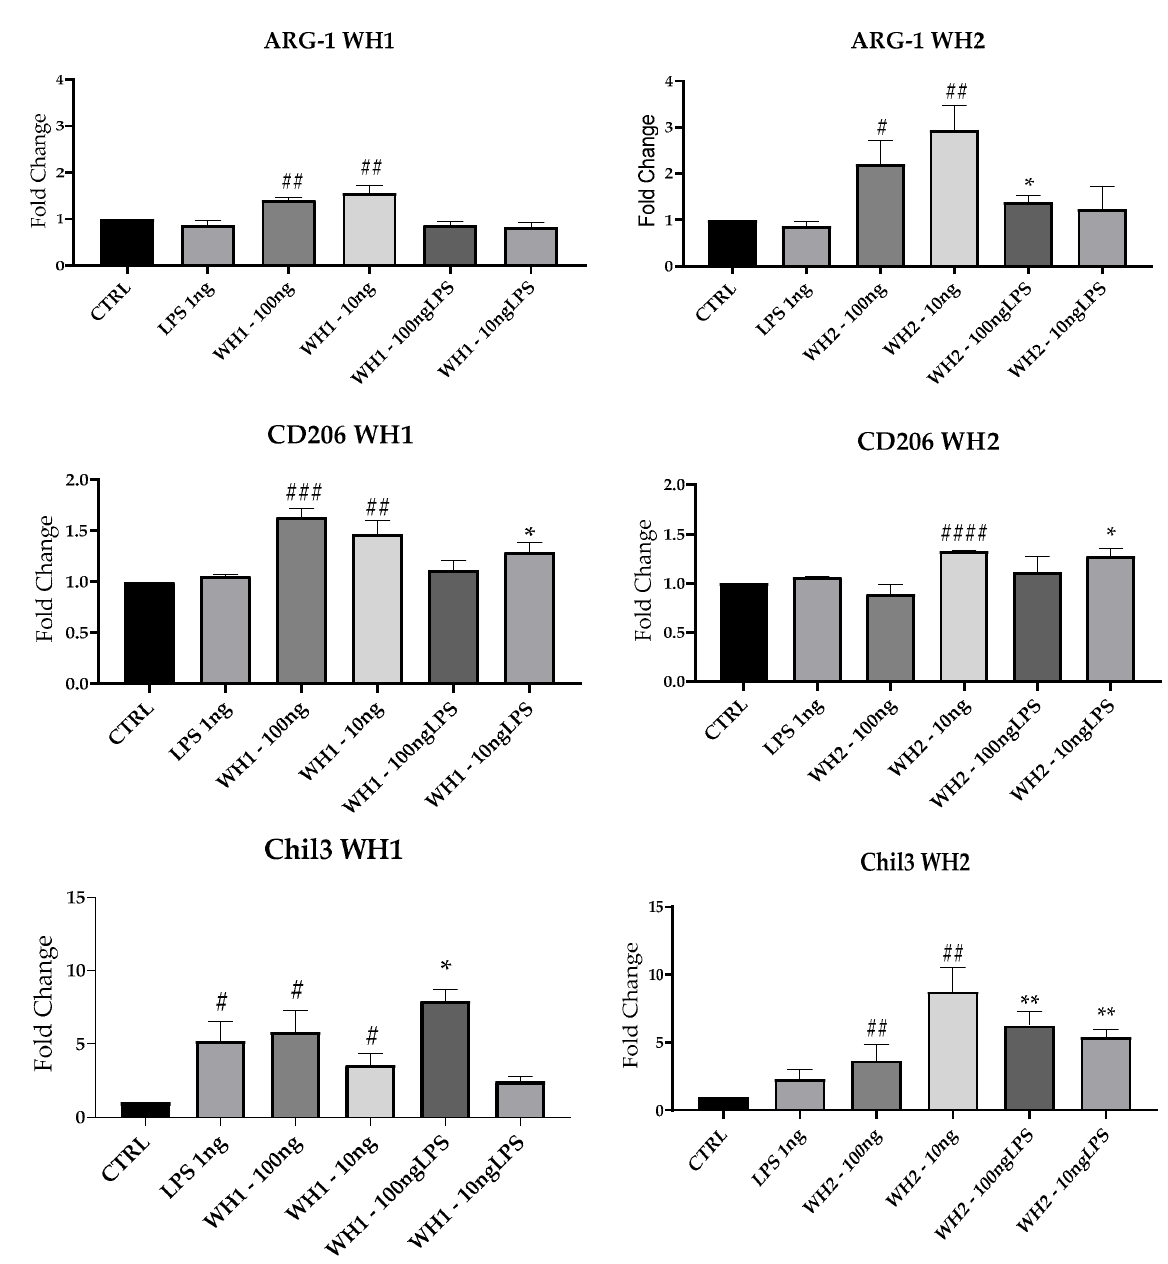
Figure 6. mRNA expression of ARG-1, CD206 and Chil3 evaluated by qRT-PCR. Data are shown as mean ± SD from three independent experiments performed in triplicate. Expression profiles were determined using the 2 − ∆∆ CT method. # VS CTRL; * VS LPS; * p < 0.05; ** p < 0.01; # p < 0.05; ## p < 0.01; ### p < 0.001; #### p < 0.0001.